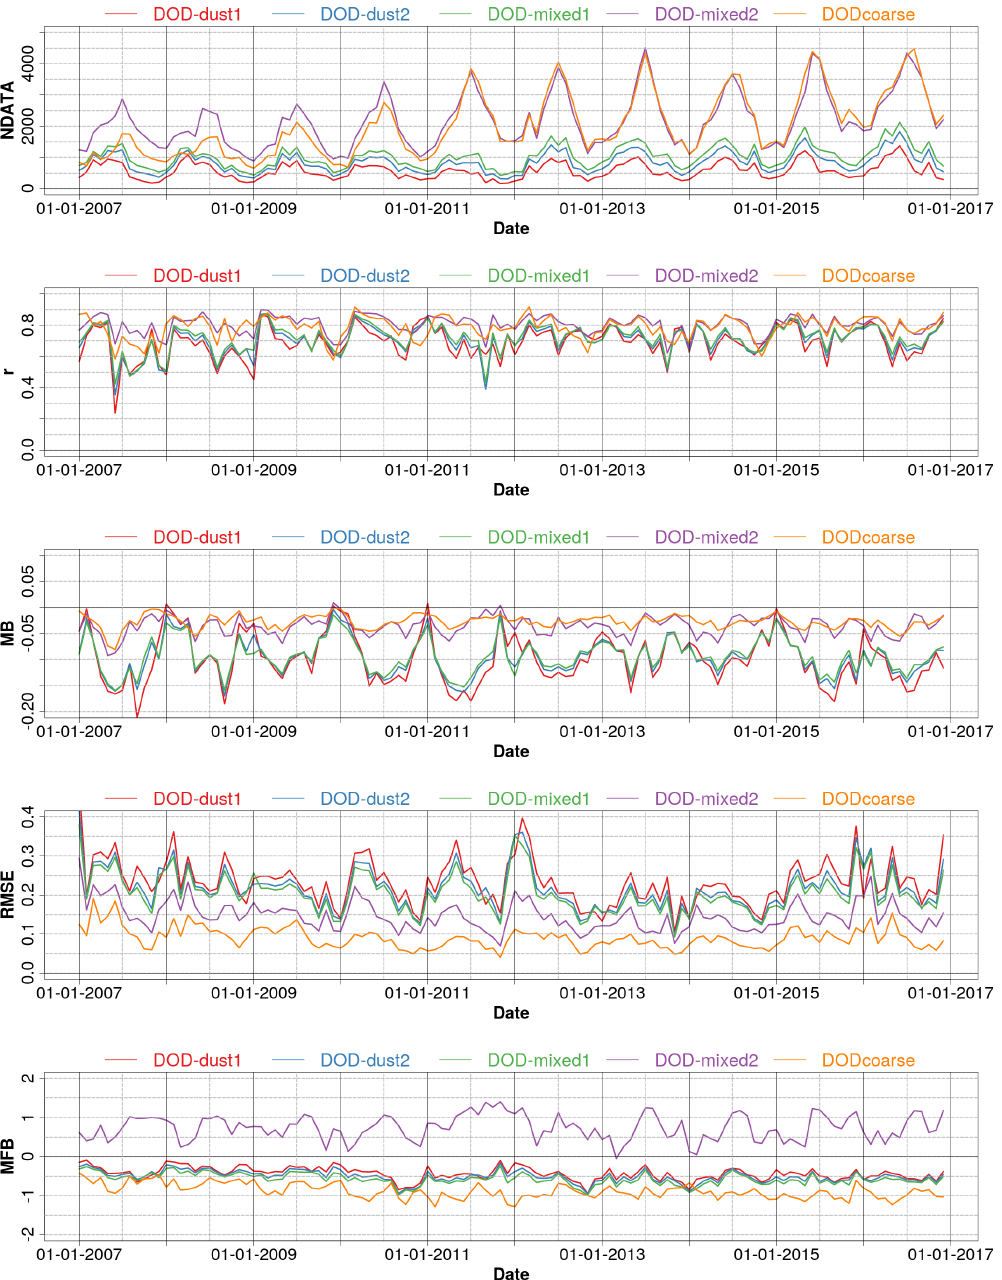
Figure 13. Time series of monthly verification statistics ( r , MB, RMSE, MFB) and number of samples (NDATA) for the reanalysis DOD and DOD coarse versus dust-filtered AERONET observations for the period 2007–2016 for the NAMEE domain. Different colours are associated with the results obtained with the different dust filters: DOD-dust1, DOD-dust2, DOD-mixed1, DOD-mixed2 and DOD coarse . The definition of each dust filter is reported in Table 6. The results are obtained using 3-hourly collocated model and observation